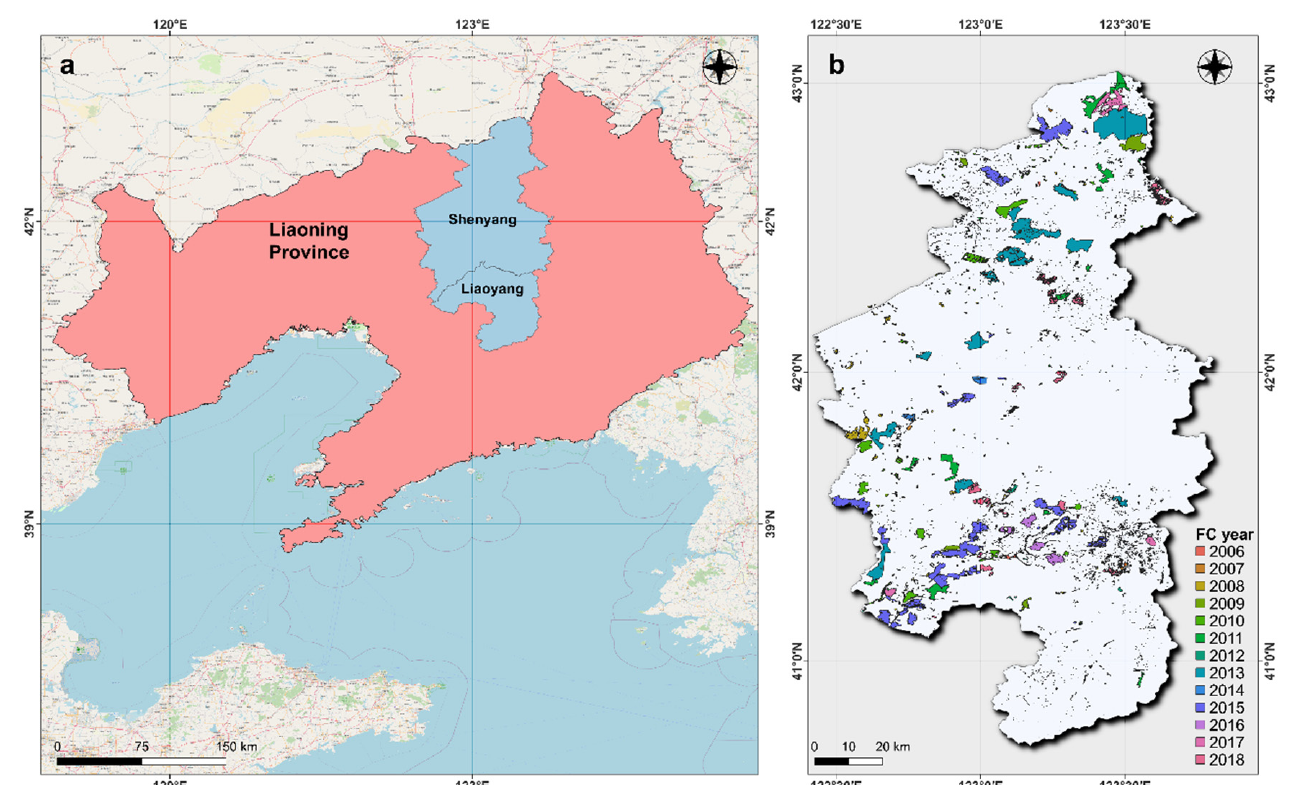
Figure 1. The location map of the study area and farmland consolidation (FC) phases marked by FC year. Liaoning Province ( a ) and our study region ( b ).